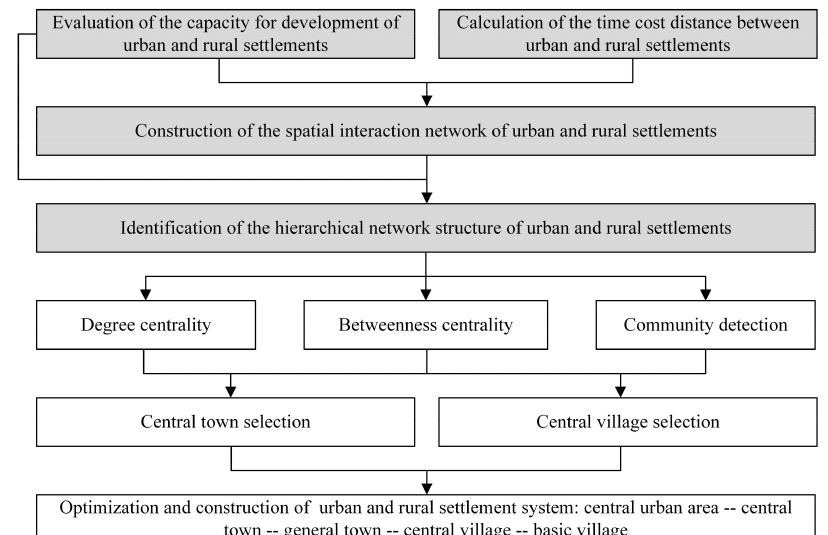
Figure 1. Method framework of the identification and optimization of the spatial structure of urban and rural settlements from a hierarchical network